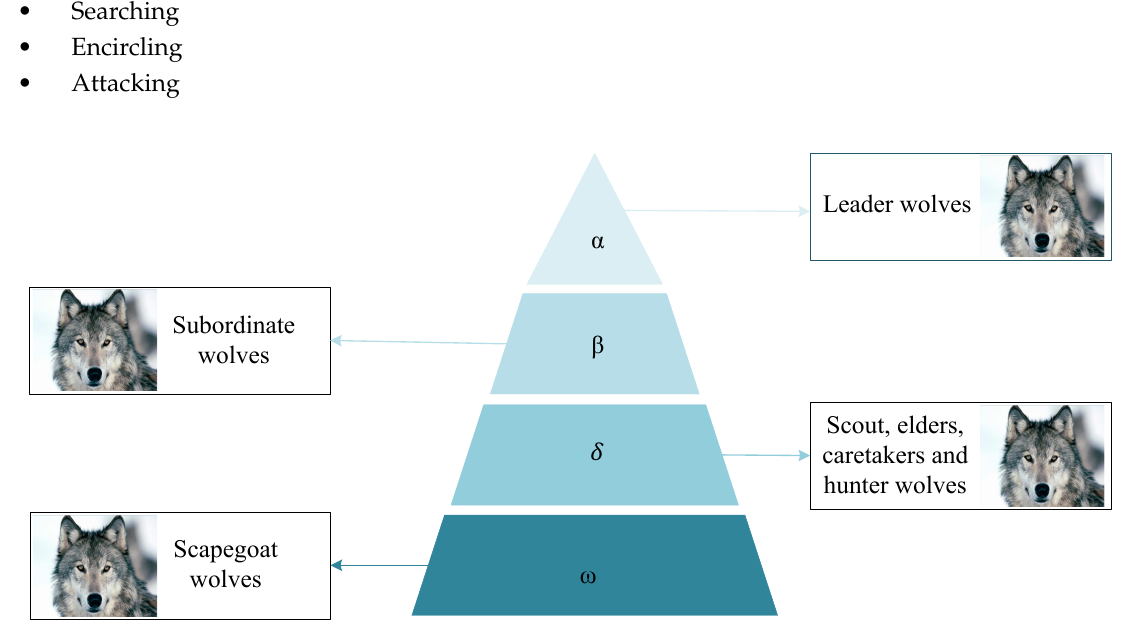
Figure 3. Leadership hierarchy of